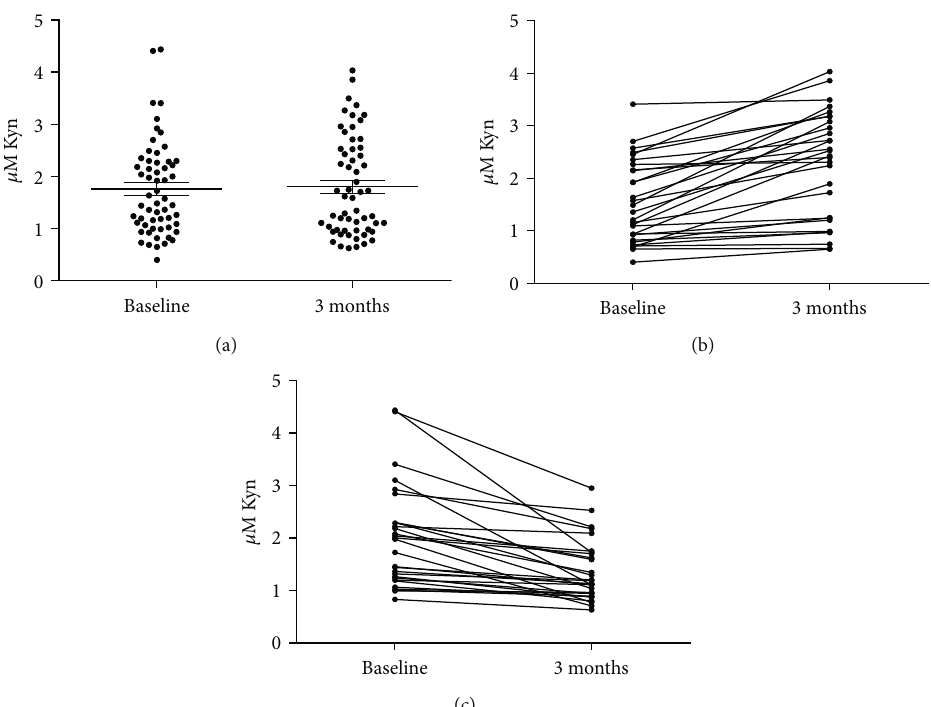
Figure 1: Kynurenine levels in plasma of Hispanic En Balance participants with T2DM following 3 months of diabetes education. (a) Kynurenine levels for all study participants ( n = 58 ) are plotted ( mean ± SEM ). (b) Paired data from the 29 En Balance participants whose plasma kynurenines decreased after 3 months. (c) Paired data from the 29 En Balance participants whose plasma kynurenines increased after 3 months. The black lines connect data points belonging to the same